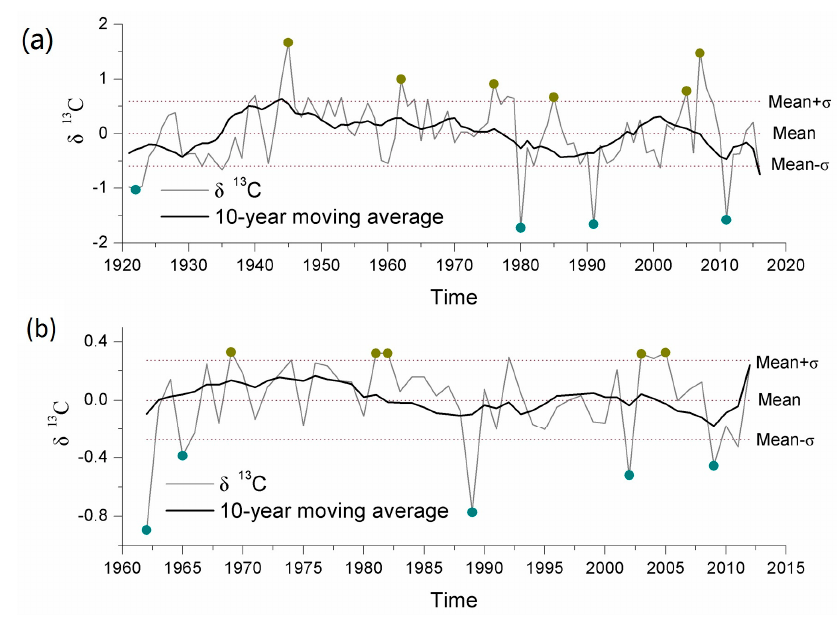
Figure 5. Tree-ring δ 13 C series of Ili ( a ) and Manas ( b ). The thick line represents the 10 year moving average. The green and blue dots represent the highest and lowest year values, respectively.